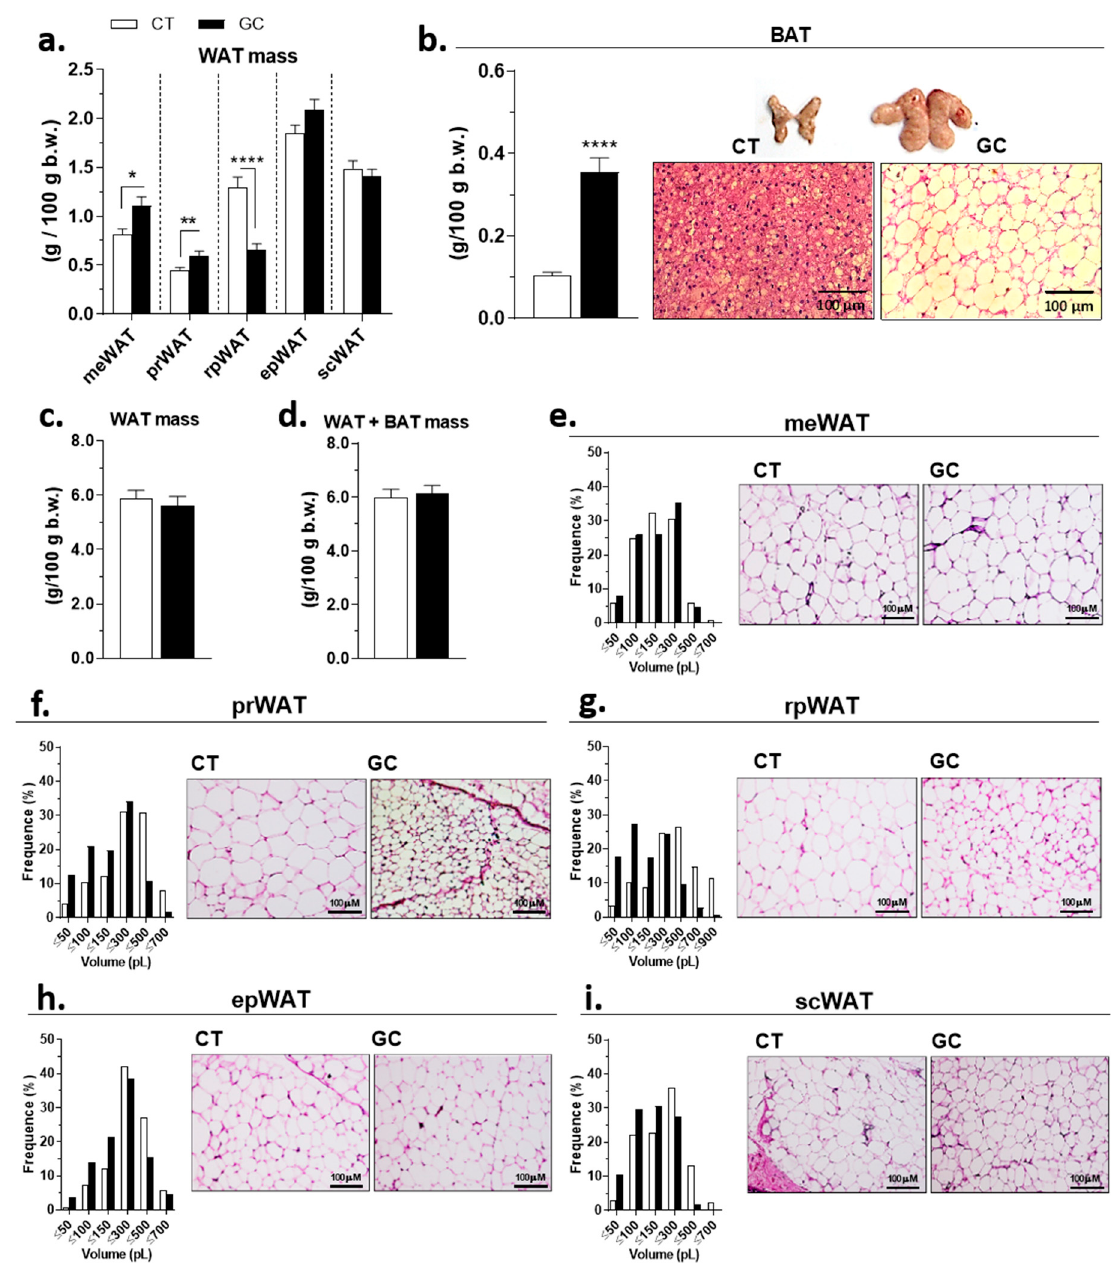
(Figure 4b). GC treatment did not change the WAT mass sum of all five different de- pots analyzed in this study (Figure 4c), as no difference was observed when considering WAT + BAT mass (Figure 4d).